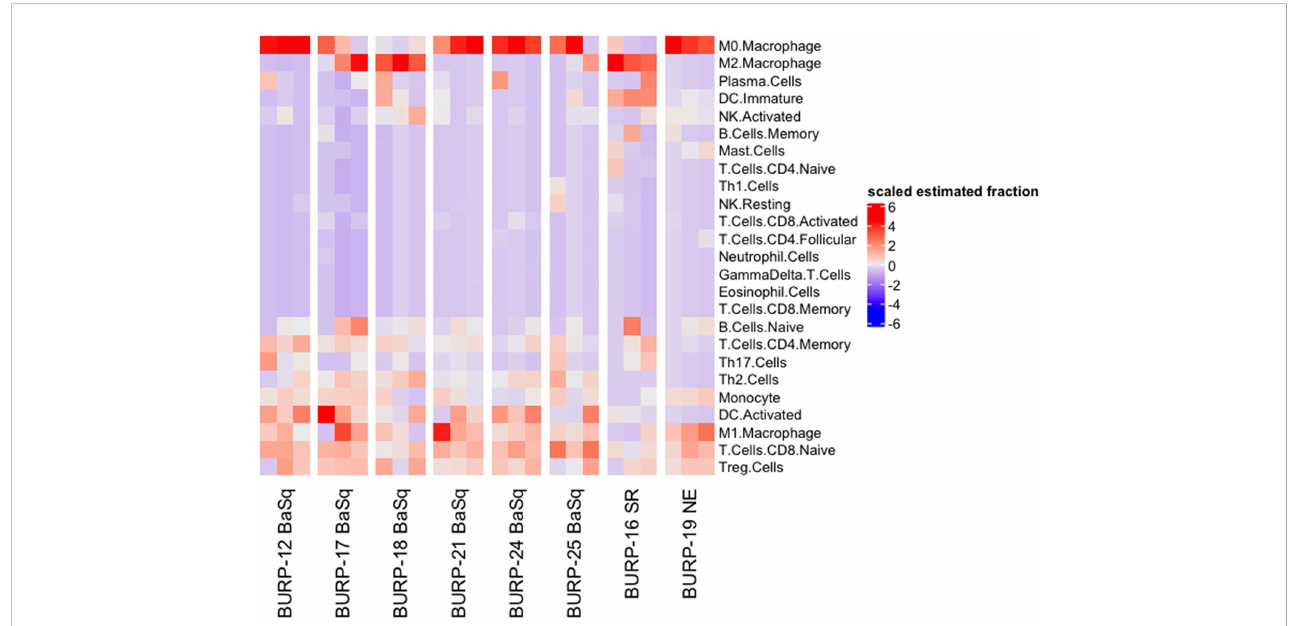
FIGURE 6 Immune contexture of BURP models. Heatmap of scaled estimated fraction of 25 immune cell signatures across the eight BURP tumor lines. The immune signatures are estimated by applying CIBERSORT deconvolution method using the ImuCC input signature. Red represents a higher scaled estimated fraction and blue represents a lower scaled estimated